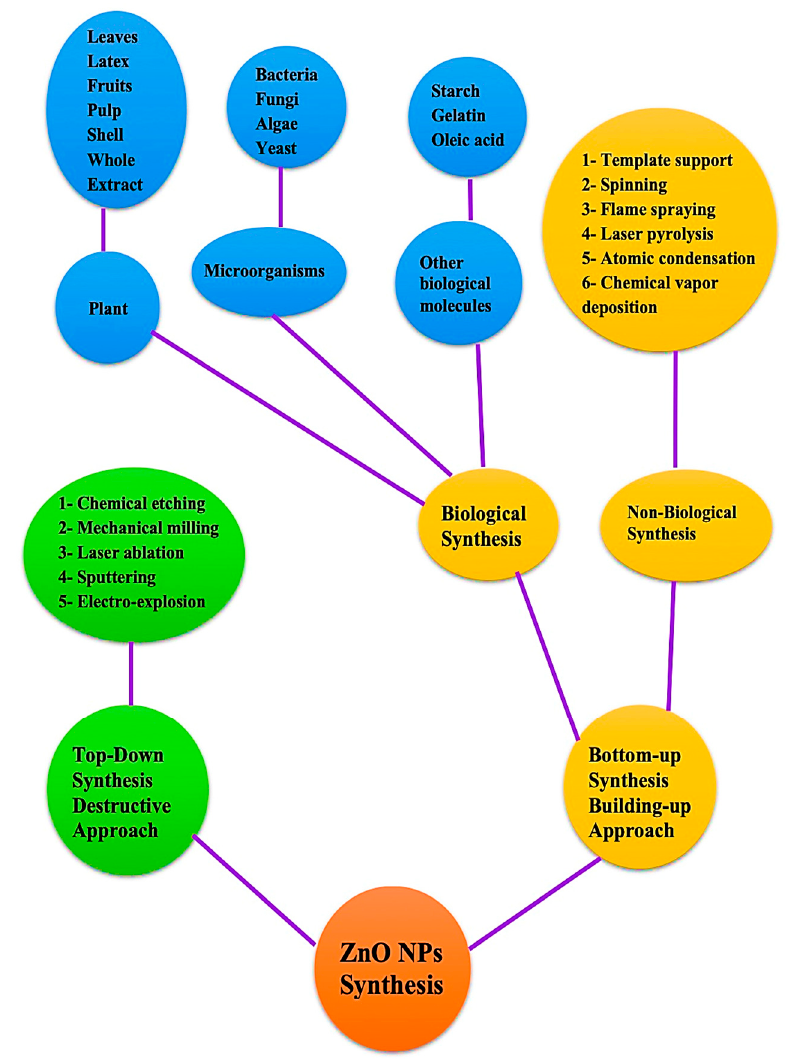
Figure 2. General methods for creating zinc oxide nanoparticles.